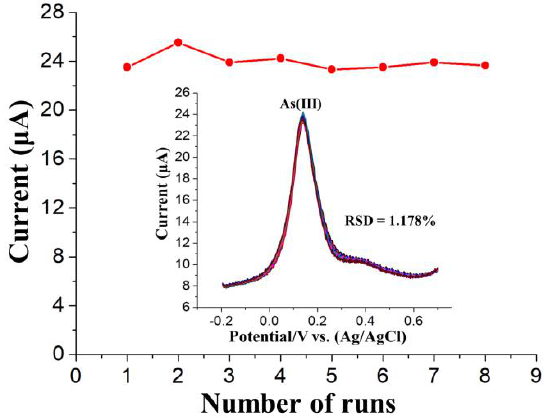
Figure 9. Eight repeated SWASV measurements of 5 µ g/L As(III) with rGO-Au nano /GCE. The insets correspond to the data collected from every SWASV curve for a total of eight measurements. RSD refers to the relative standard deviation.